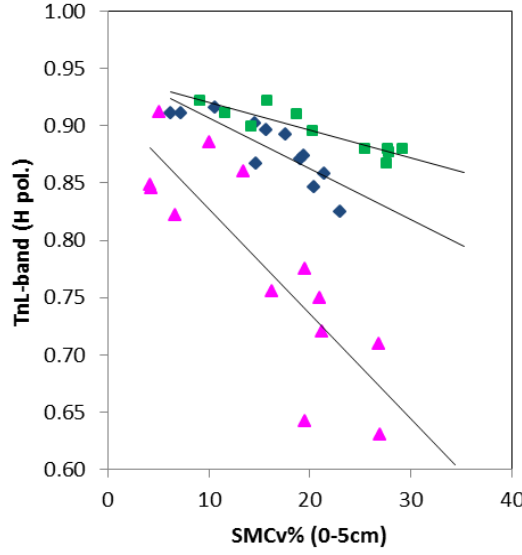
Figure 4. Tn (L band, Hpol., Θ = 10° – 20°) as a function of volumetric SMC (0 – 5 cm) for three different ranges of surface roughness Hstd ( • = < 0.4 cm, ◊ = 0.7 – 1.2 cm, = 1.2 – 3.0 cm).